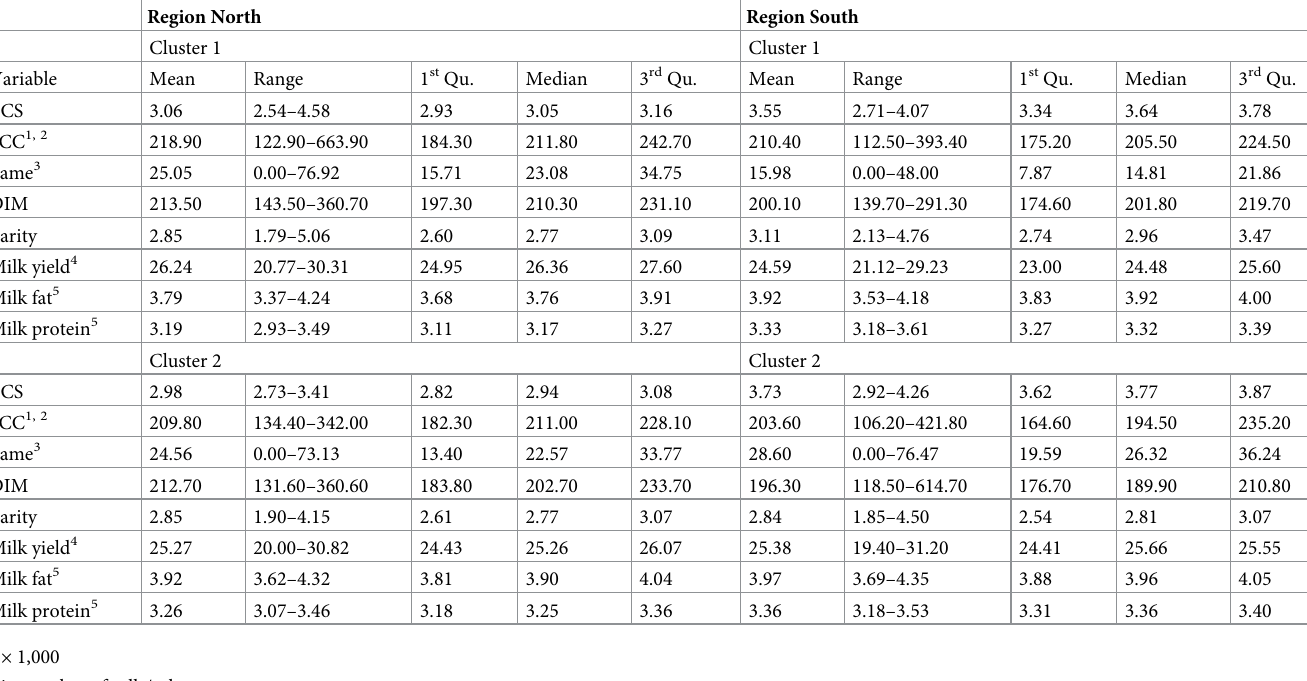
Table 2. Descriptive cluster statistics of the F . hepatica cluster analysis in regions North and South (continuous variables). Region